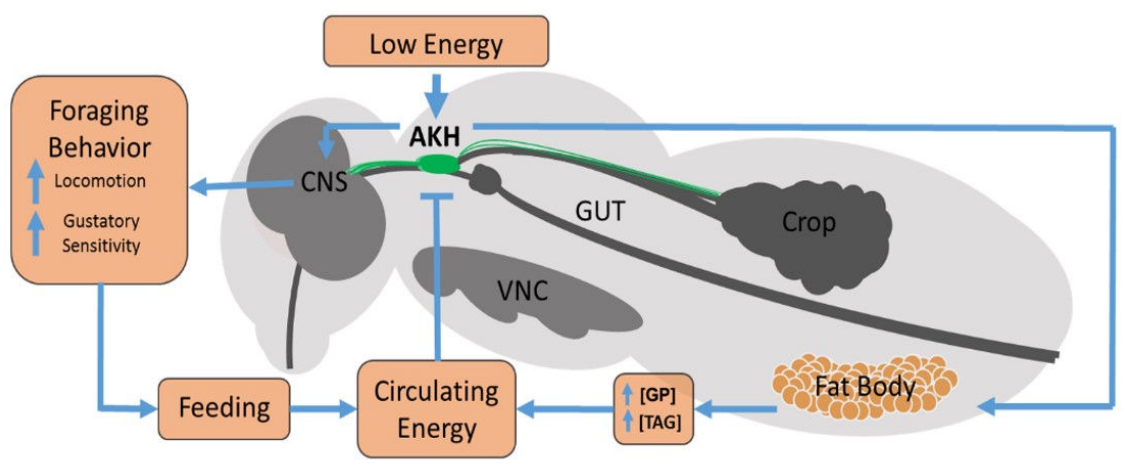
Figure 1. Model of AKH action. AKH producing cells (APCs) possess nutrient sensors which become active during low energy (high metabolic demand and/or low nutrient availability). This facilitates the release of AKH where it interacts with receptors located on the fat body and stimulates glycogen phosphorylase (GP) and TAG lipase to raise circulating levels of carbohydrate and lipid energy reserves. These inhibit the further release of AKH from APCs. AKH also binds to receptors present in the CNS, where AKH regulates other behavioral changes such as locomotor activity and is thought to act to modulate gustatory sensory